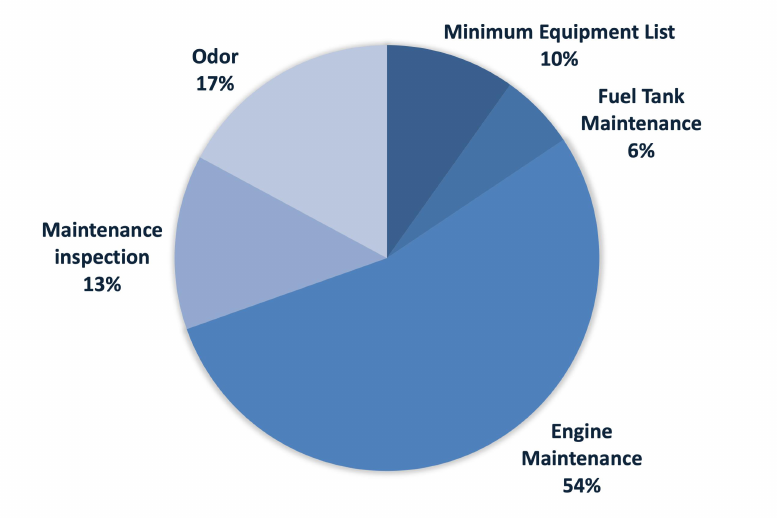
Figure 6. Proportion of reports per subcluster for Cluster 6 ‘Maintenance’.